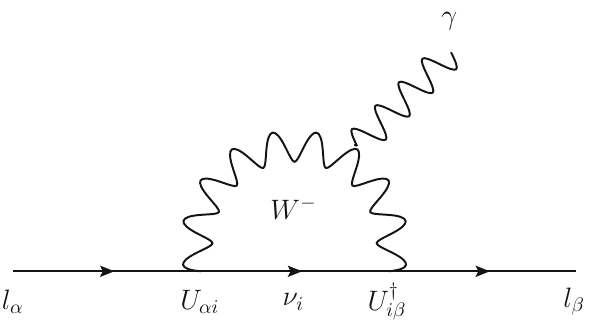
Fig. 3 Lepton flavor violating decay at one